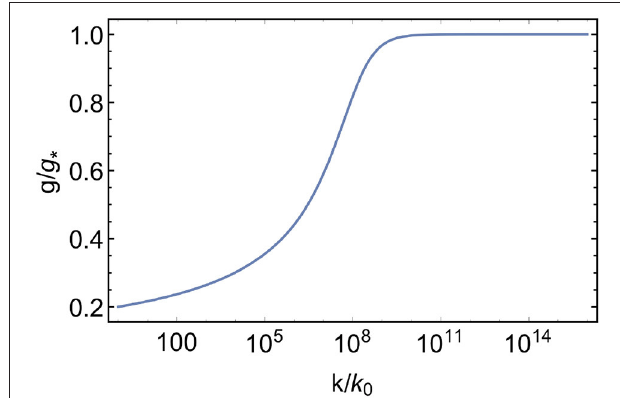
FIGURE 1 | Schematic RG flow for an asymptotically safe coupling. Beyond the transition scale at k / k 0 10 9 , (approximate) scale-invariance is realized; ≈ full scale-invariance is realized asymptotically at k / k 0 → ∞